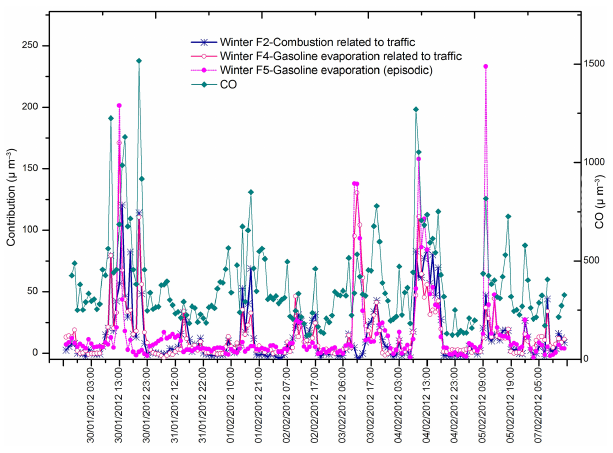
Figure 6. Pollution rose by a factor of 5 contribution (µgm − 3 ) in